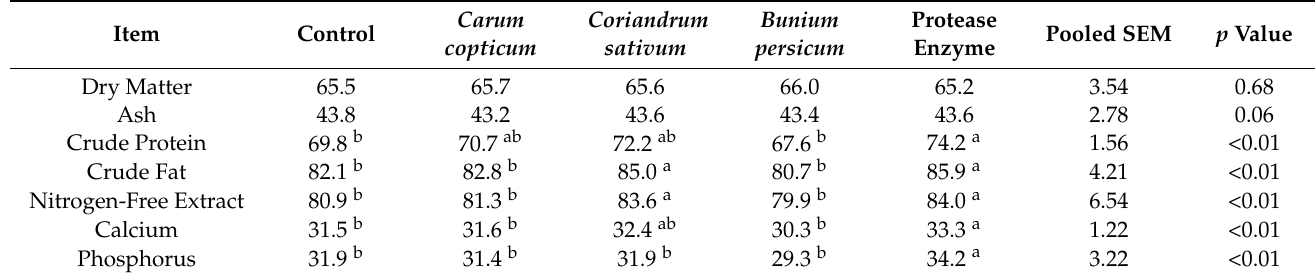
Table 3. Effect of adding herbal plant feed additives and protease on apparent ileal nutrient digestibility (%) in broilers.